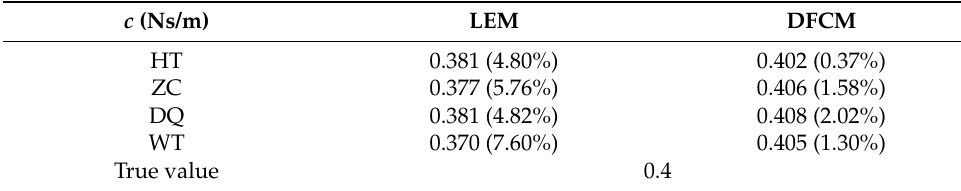
Table 2. Estimated results and errors of the damping